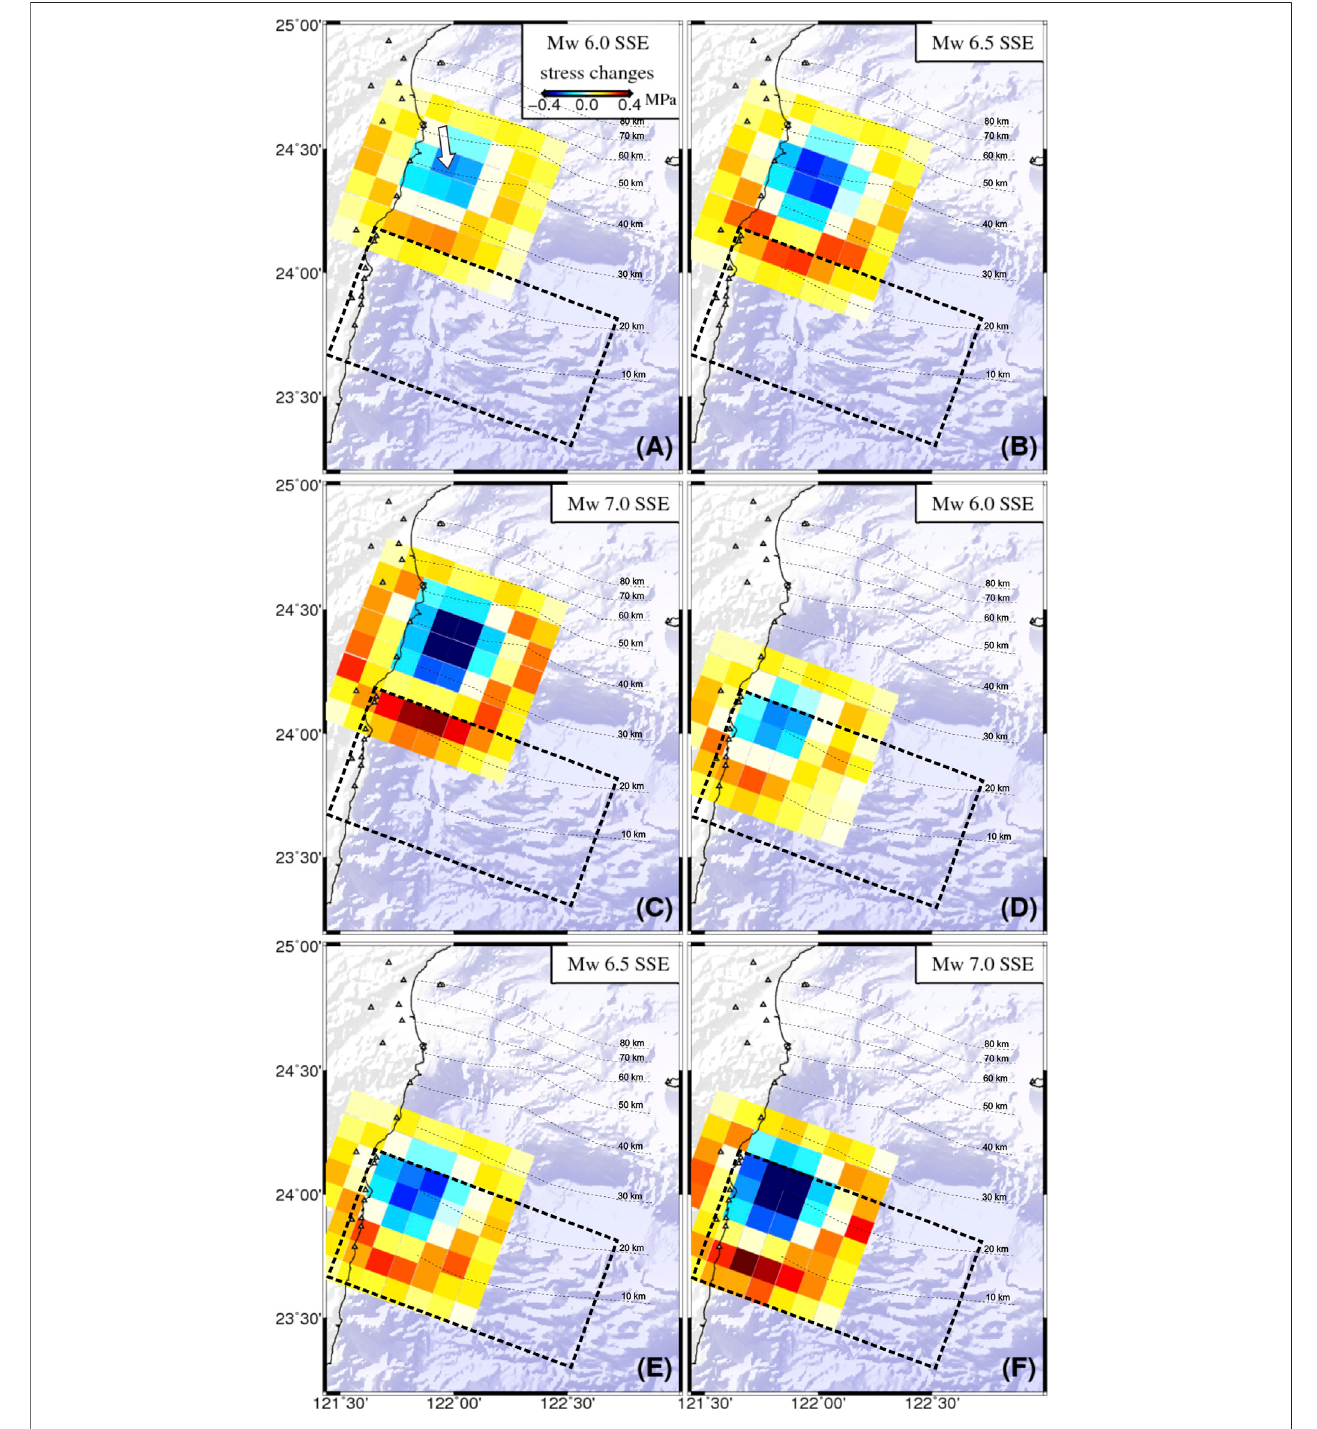
FIGURE 6 | Examples of shear stress changes on the Ryukyu fault caused by synthetic SSEs with moments from M w 6.0 to 7.0. The white arrow indicates the slip direction of each SSE. (A – C) Scenarios of SSEs from the downdip depths of the Ryukyu fault (black dotted rectangles). (D – F) SSEs within the downdip region.